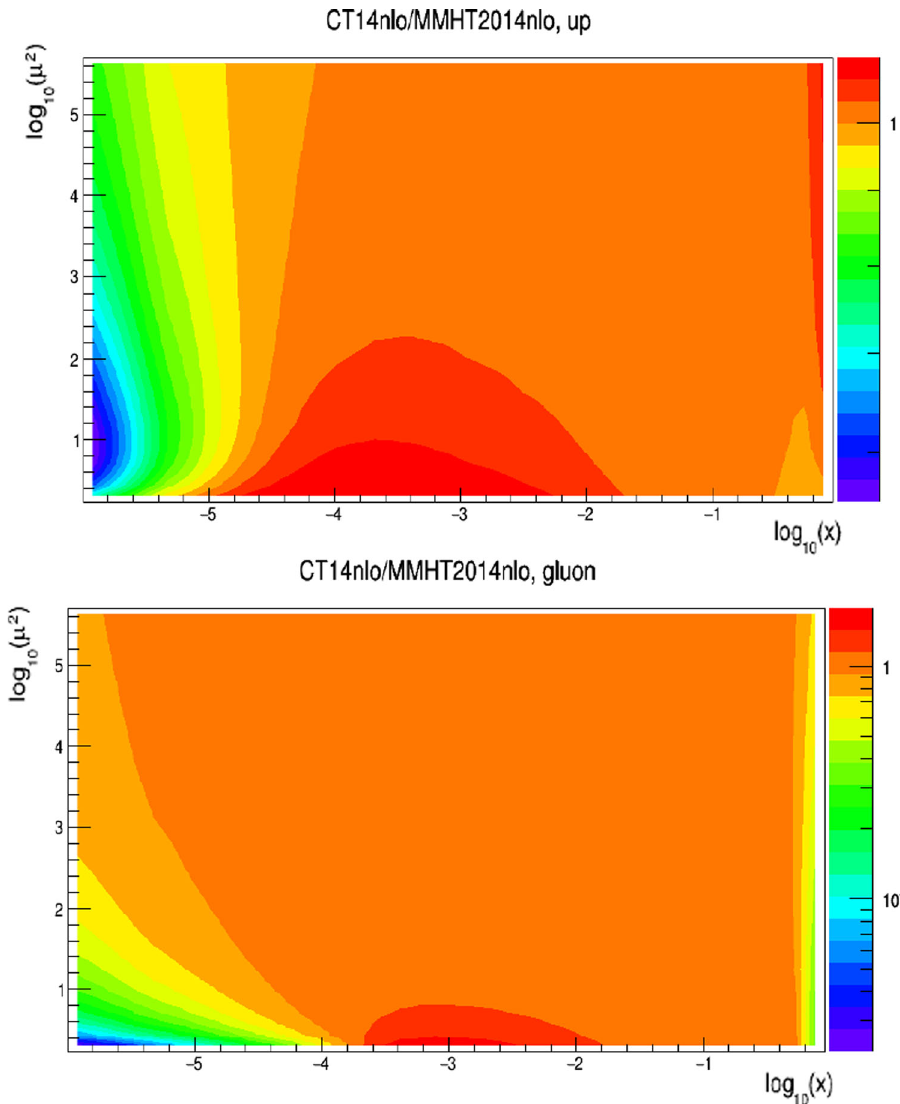
Fig. 1 The top (bottom) panel shows the fraction of CT14nlo/MMHT2014nlo for up quark (gluon)